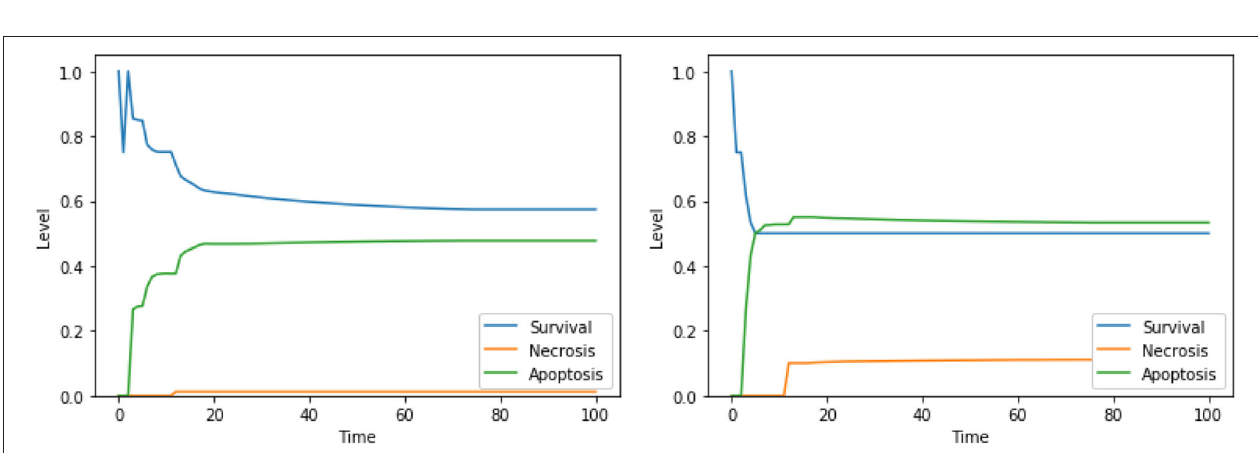
FIGURE 10 | Simulation of the DFM in the PKA high condition, using the perturbations “Ca 2 + IS high, ERK IS low, N-glycosylation IS low” (left) and “DeltaPsi IS low, ERK IS low, UPR IS high” (right) .